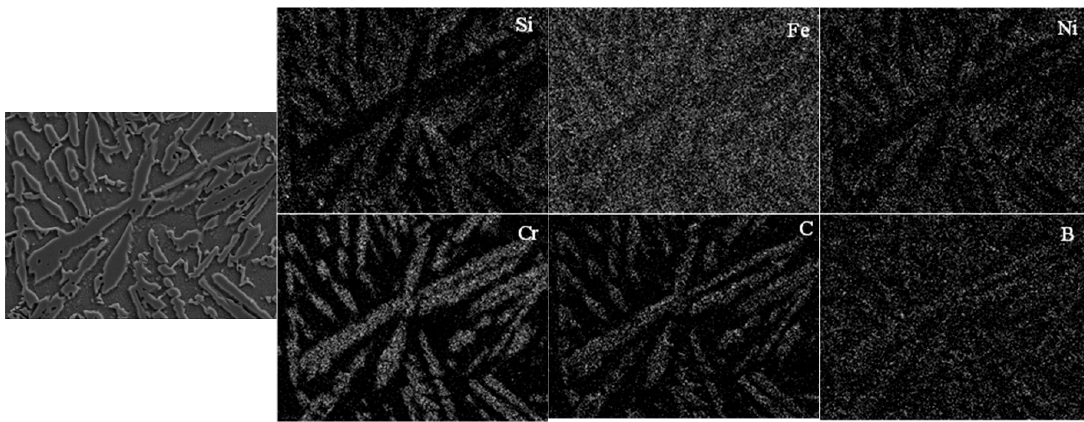
Figure 4. EDS mapping of laser cladded Ni45 + 40 wt.% high-carbon ferrochrome coating.